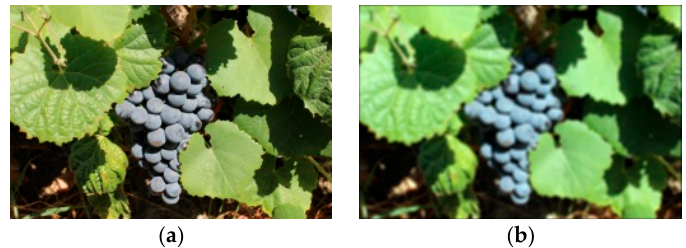
Figure 4. Independent component analysis: ( a ) DRGV image; ( b ) Convolution output of ( a ) with the first independent components filter (ICF).